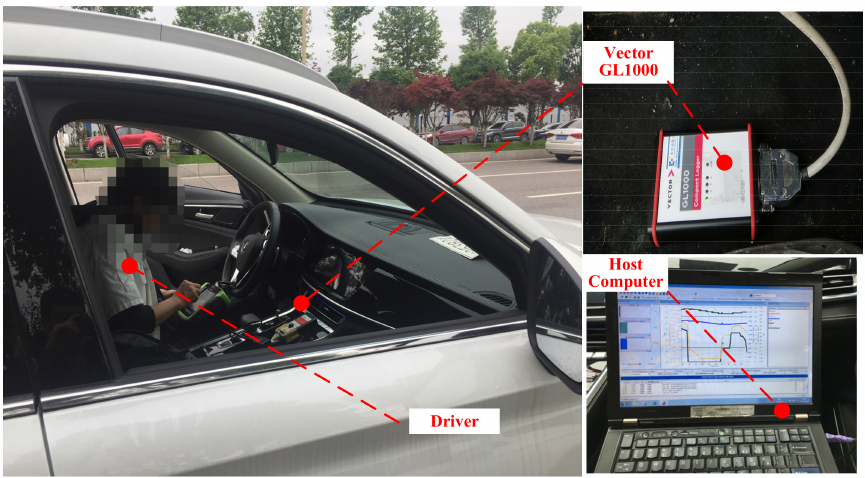
Figure 10. Test data acquisition